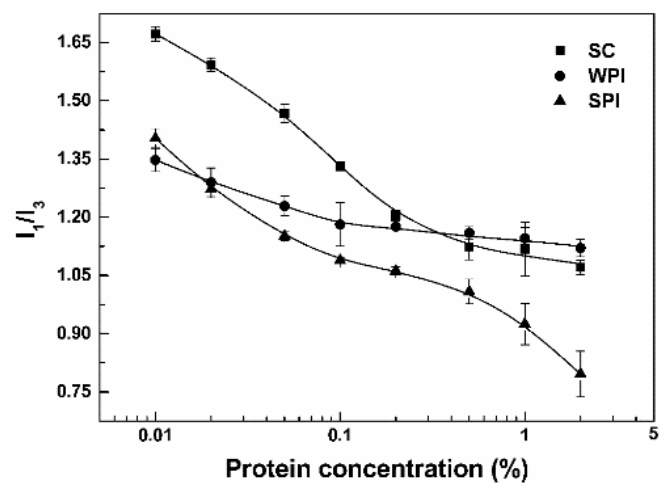
Figure 1. I 1 /I 3 of whey protein isolate (WPI), sodium caseinate (SC) and soy protein isolate (SPI) solutions at various concentrations.